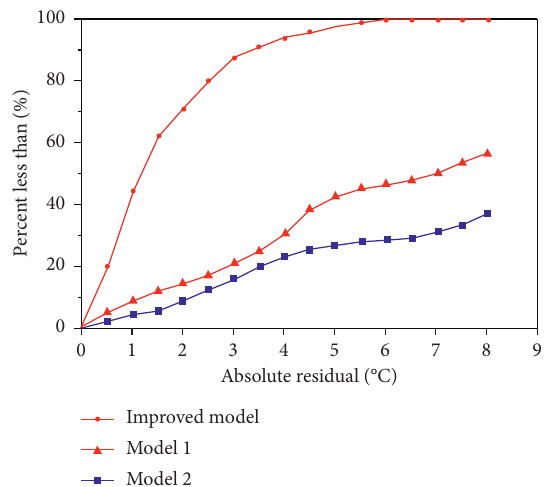
Figure 10: Comparisons of prediction errors between Model 1, Model 2, and the improved